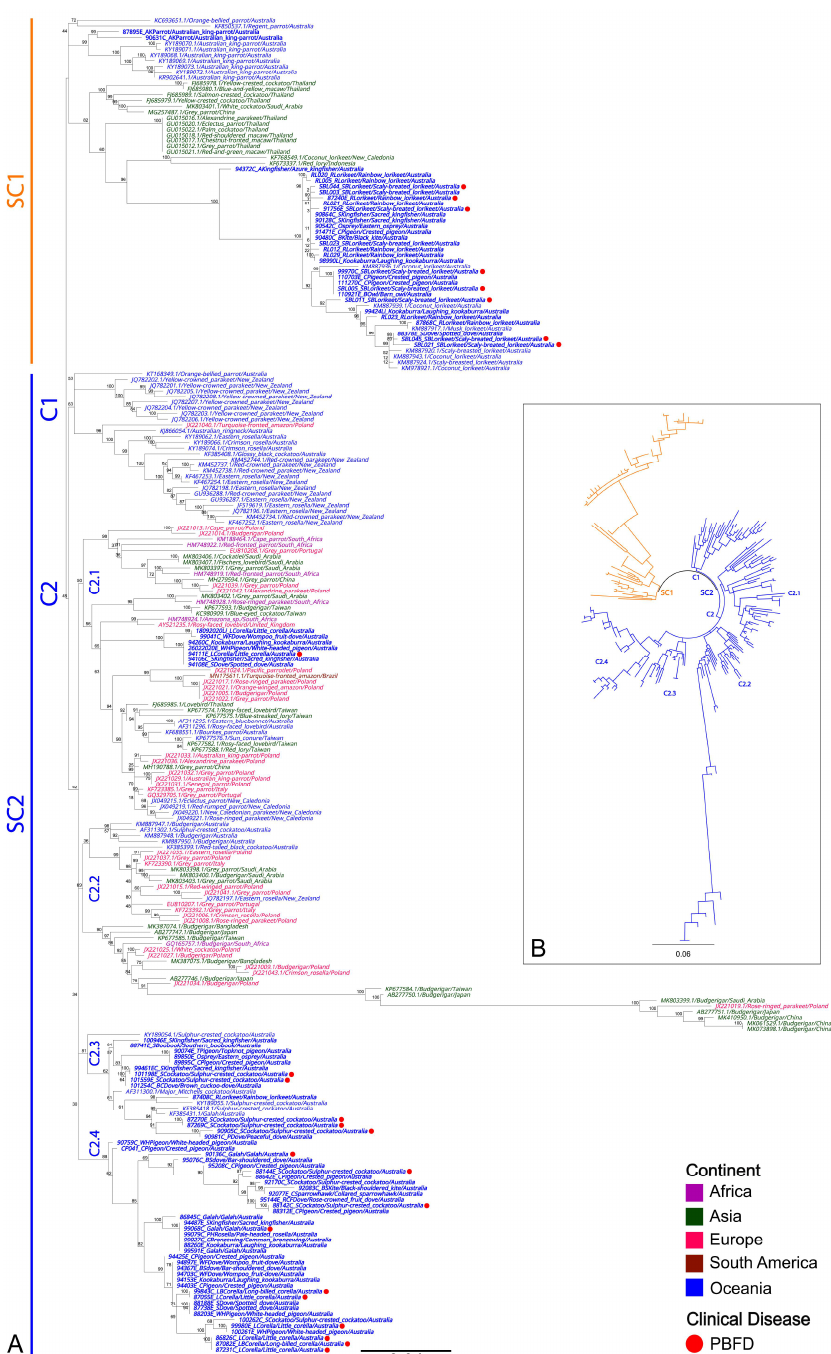
Figure 4. Phylogenetic relationships between 89 BFDV sequences detected from avian species in this study and 145 global reference strains ( A ). BFDV sequences are named by their corresponding GenBank accession number/host/country of origin and coloured text according to their continent of isolation. Sequences from Oceania are presented in blue, with sequences generated in this study being additionally boldened. A red circle is placed adjacent to sequences detected from birds that presented with disease signs consistent with PBFD. Bootstrap values are shown as a percentage. ( B ) The inset tree is broadly denoting BFDV SC1 and SC2 overall phylogeny between all publicly available BFDV rep gene sequences. The midpoint-rooted maximum likelihood phylogenetic trees were constructed using IQTREE2. The scale bar indicates the number of nucleotide substitutions per